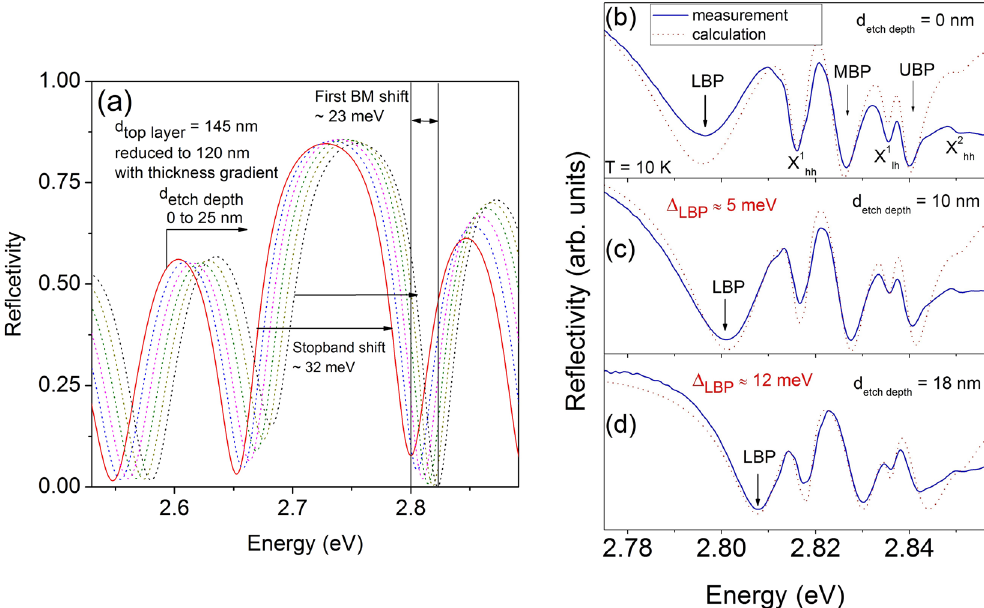
Figure 2. ( a ) Calculated reflectivity spectra of the cold Bragg structure obtained when the thickness of the upper layer is continuously reduced for moving along the thickness gradient, eventually ending at a 25 nm reduction achieved at the leading edge of the structure (see Fig. 1(a)). ( b – d ) Region of interest of the measured microreflectivity spectra (solid lines) of the Bragg sample at T = 10 K for different top layer thicknesses in comparison to the calculated spectra (dotted lines). Δ LBP indicates the shift of the LBP